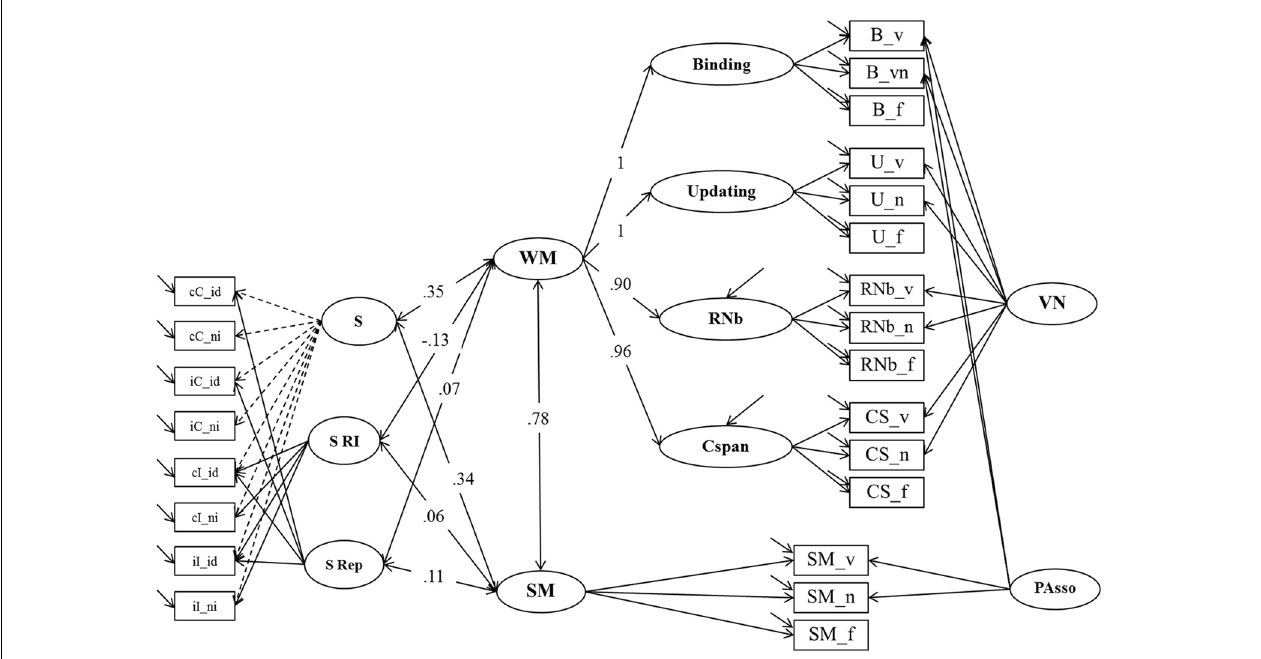
FIGURE 7 | Structural Equation Model testing the relationship of WM, SM and Response Inhibition un the Simon task (Model 4b). Binding, Updating, Recall 1-back (RNb) and Complex Span (Cspan); VN, Verbal-Numerical Content Factor; SM, Secondary Memory; PAsso, Learning Paired-Associations; _v, verbal indicators; _n, numerical indicators; _f, figural indicators; _lc, letter-color; _wn, word-number; _ll, location-letter; CS, Cspan